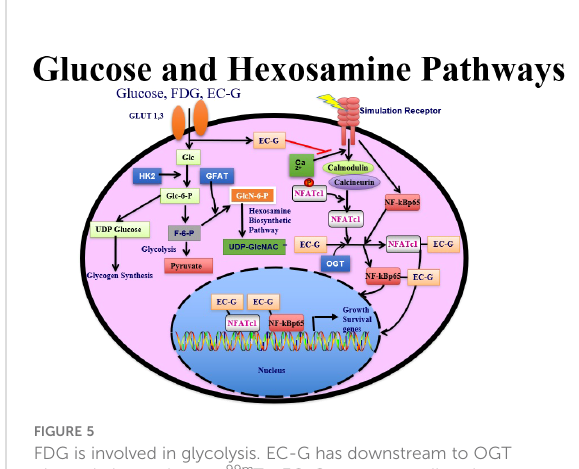
FIGURE 5 FDG is involved in glycolysis. EC-G has downstream to OGT glycosylation pathways. 99m Tc-EC-G measures cell cycle progression in